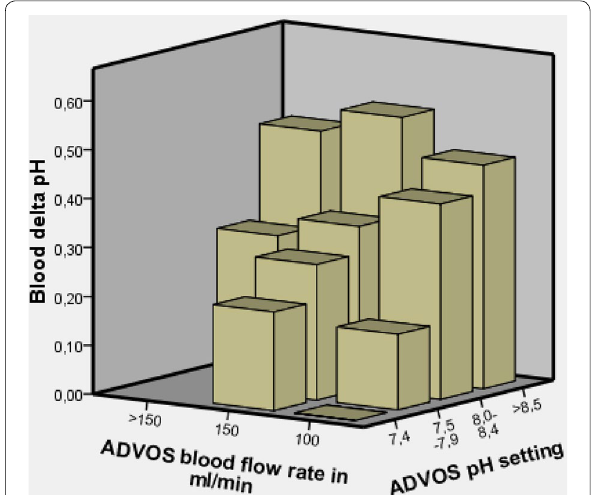
Fig. 2 Dialysate blood flow rate, dialysate pH setting of the ADVOS device impact the pH-difference between inlet and outlet (delta